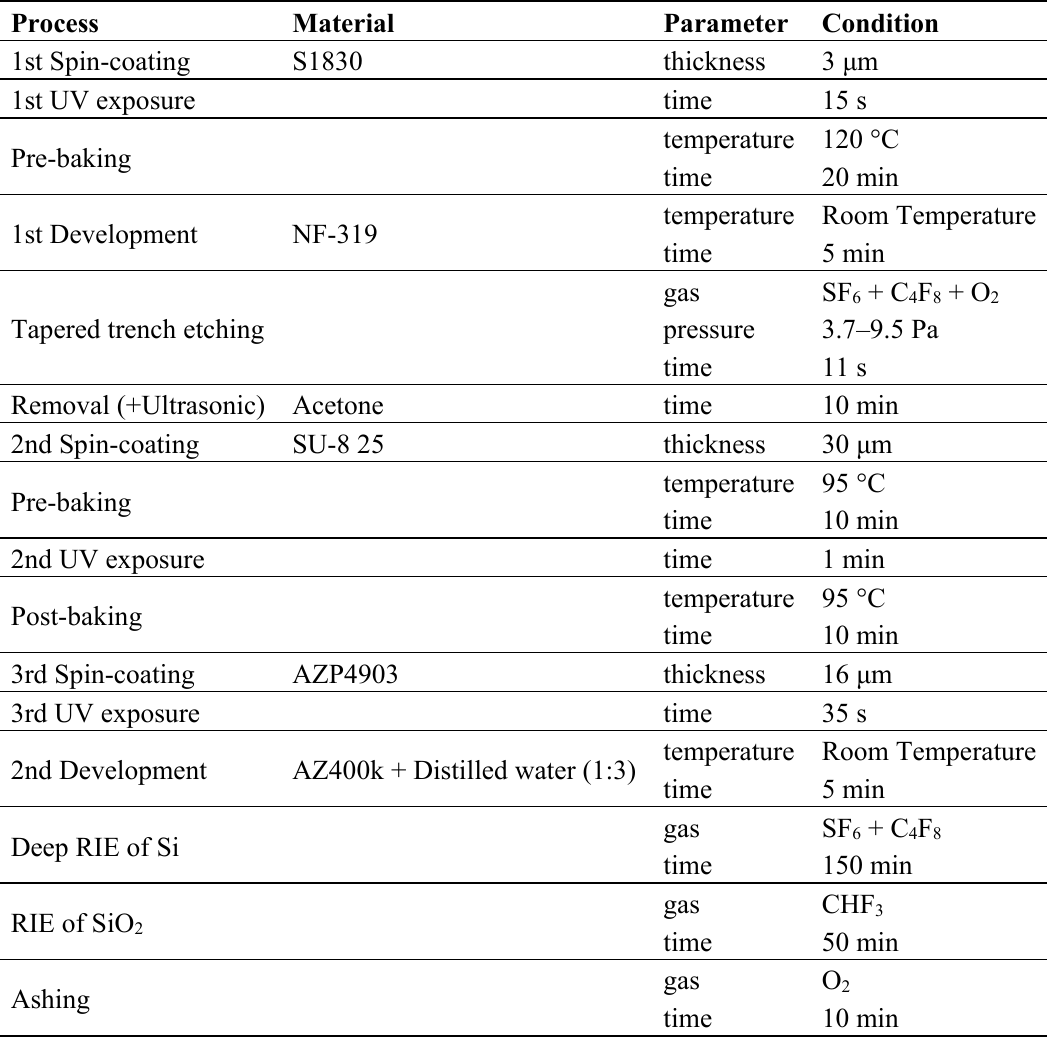
Table 2. Process conditions to fabricate X-ray